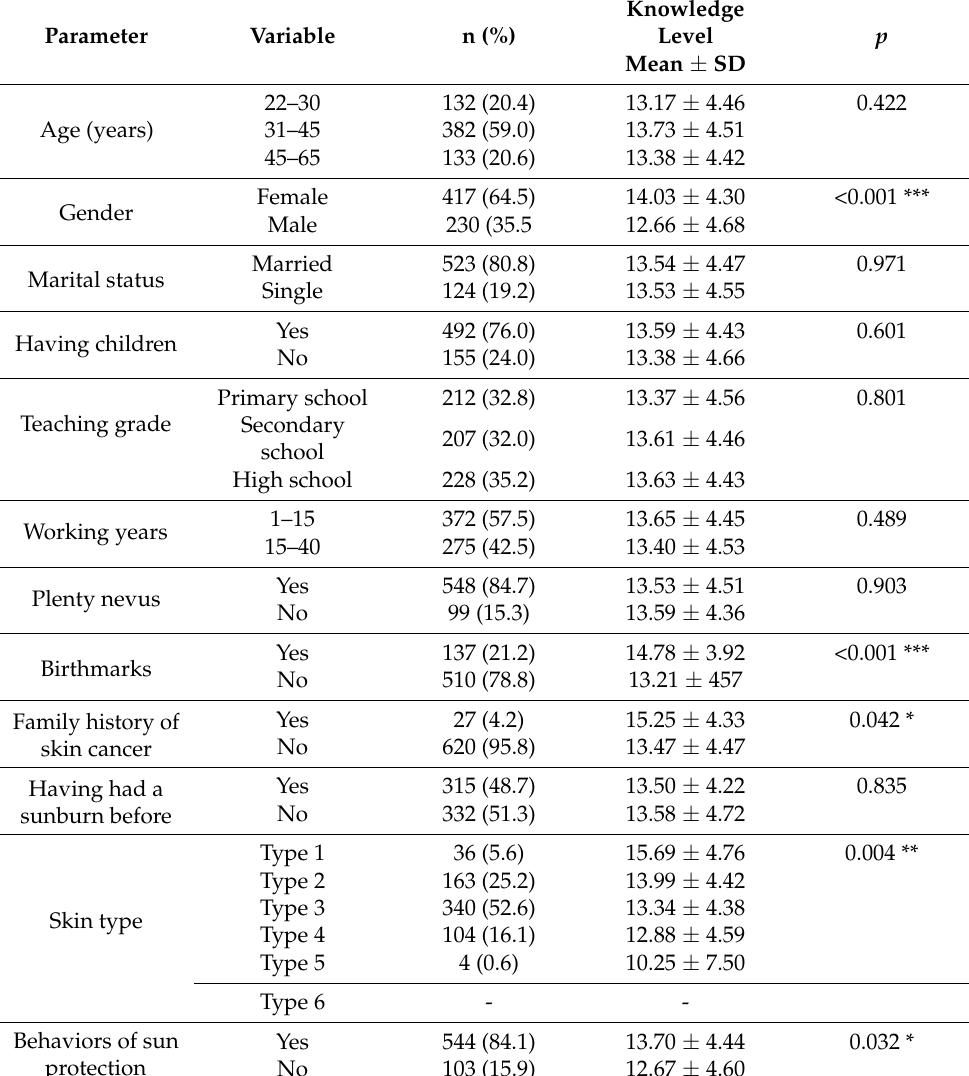
Table 1. Sociodemographic characteristics of the teachers and their knowledge levels regarding skin properties and skin